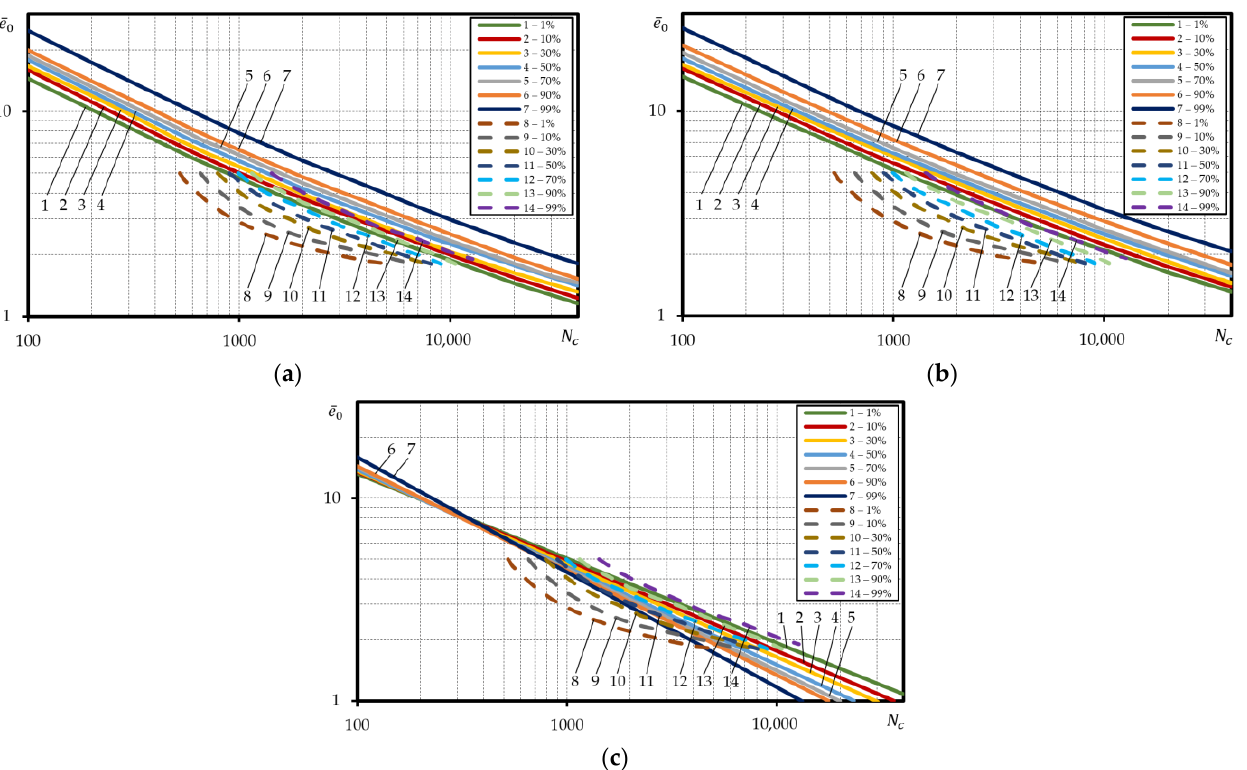
Figure 8. Comparison of the calculated probabilistic low-cycle fatigue curves under strain-controlled loading with the experimental ones for steel 115Cr2MoVA; straight lines ‒ calculated, dashed lines ‒ experiment; according to: ( a ) — Equation (3), ( b ) — Equation (5), ( c ) — Equation (6).